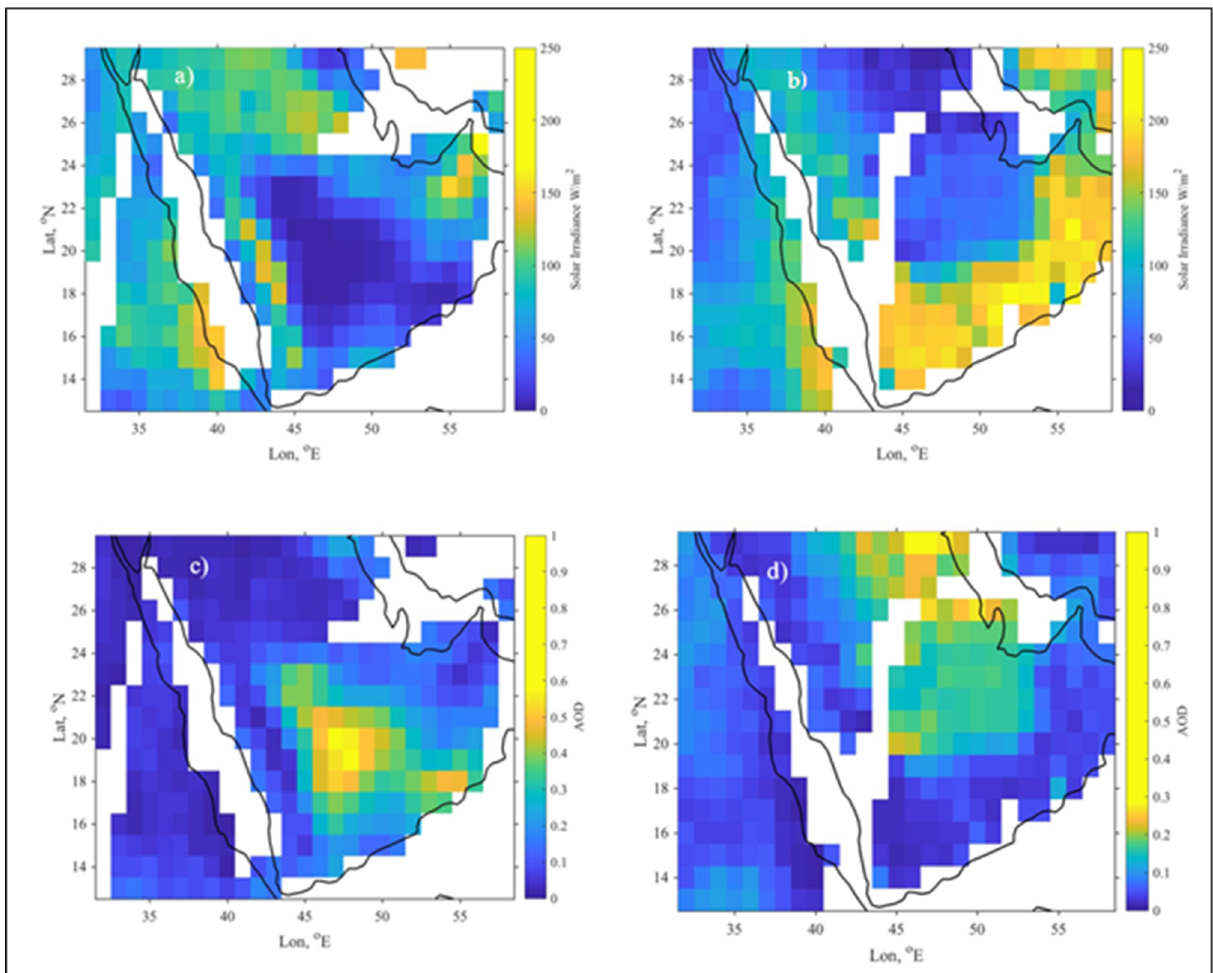
Figure 11. Effect of 11 March 2009, a major dust event, on solar irradiance over the AP on ( a ) 3 March 2009, ( b ) 18 March 2009; and on AOD over the AP for ( c ) 3 March 2009, and ( d ) 18 March 2009. Table 4. Model performance metrics.